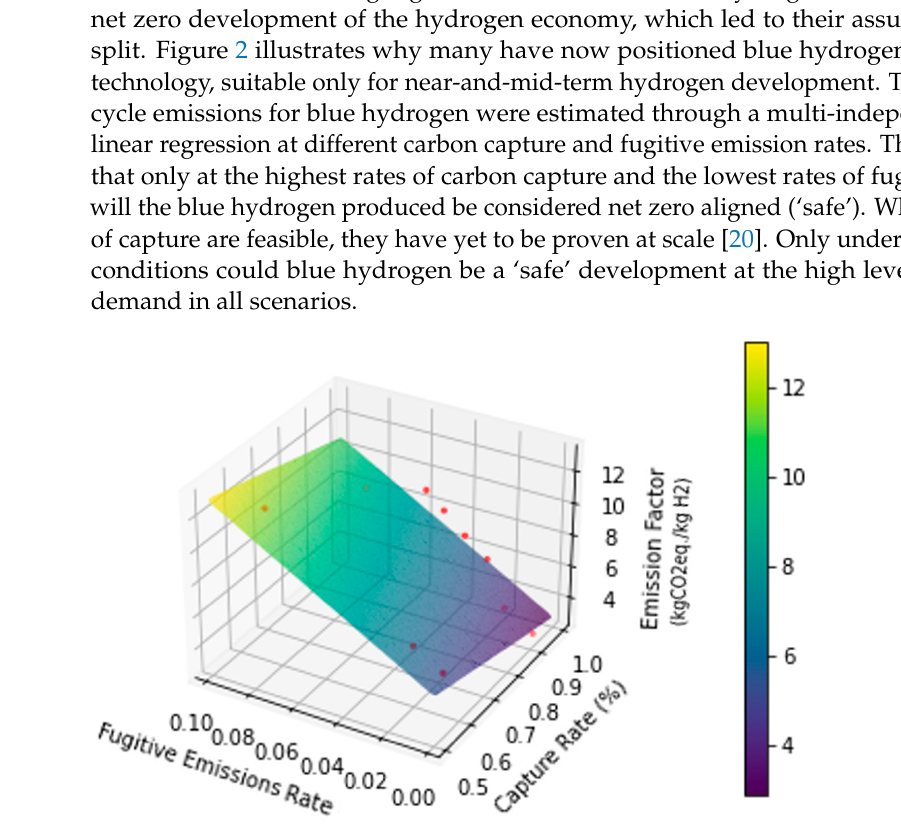
Figure 2. Linear regression (represented as the surface) of the life cycle emissions of blue hydrogen according to fugitive emission and capture rates, using data from [17,20] where actual data points are represented by the red dots. By this assessment, only operational combinations of approximately >95% capture and <1% fugitive emissions would lead below even current EU Taxonomy guidelines. Only by having near zero fugitive emissions and near perfect capture would blue hydrogen thus exist in a “safe” space for net zero development.